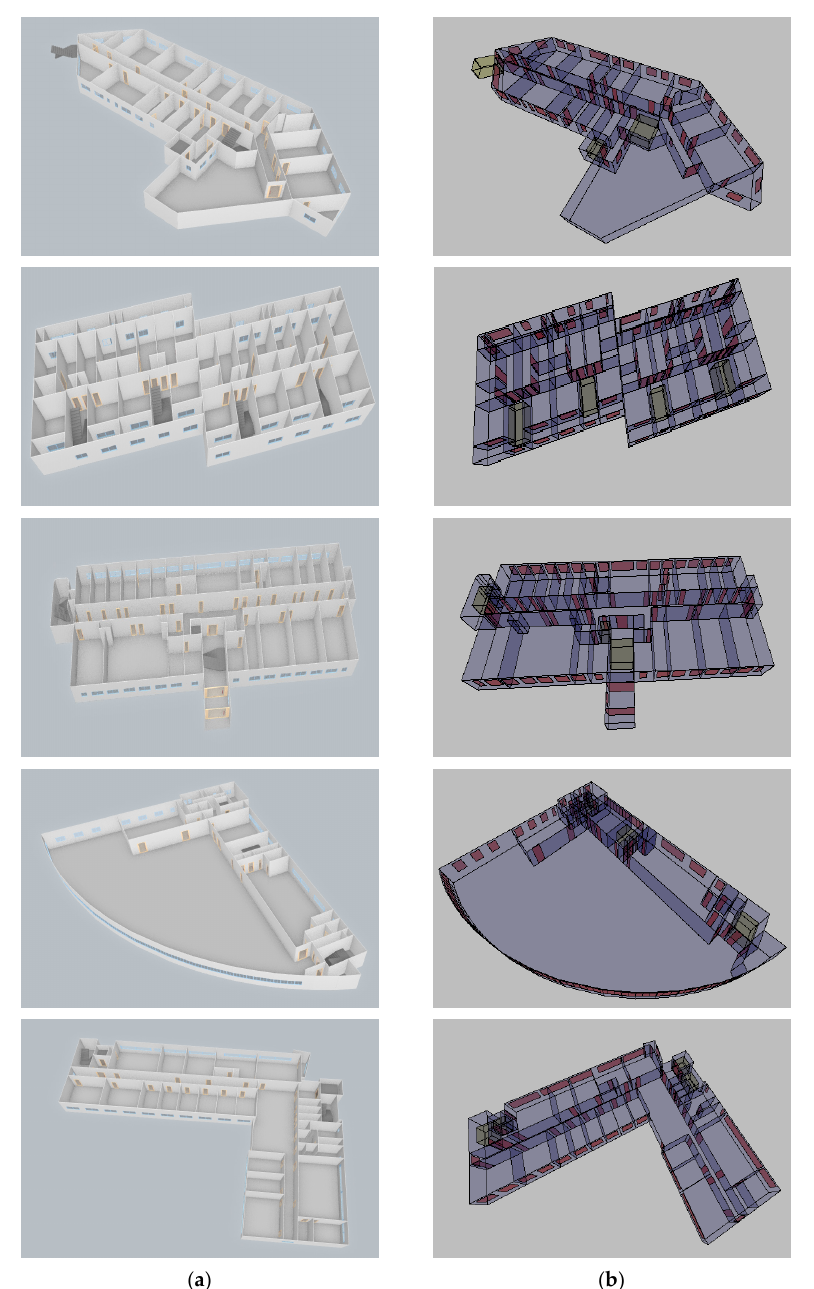
Figure 5. Example of 3D indoor models based on ( a ) JOSM, and ( b )